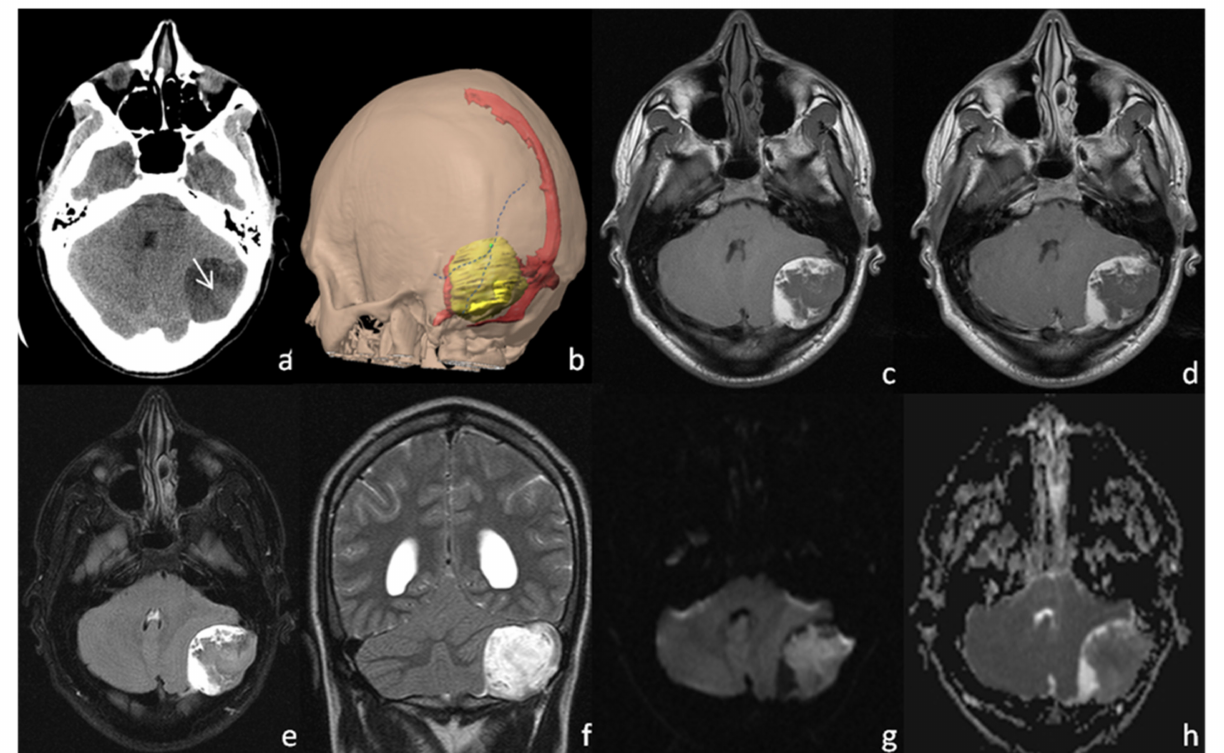
Figure 2. Case 2: CT scan ( a ) showing a hypodense left asterional lesion with a central, slight hyper- dense area ( a , white arrow), corresponding to an area of diffusion restriction on DWI/ADC ( g , h ). A 3D pre-surgical reconstruction model ( b ) was performed to correctly identify the relationships among the asterion (green dot), which is the intersection of parietomastoid, lambdoid and occipitomastoid sutures (blue dotted lines), the dermoid cyst (yellow) and the adjacent venous system (red). The 1.5 T MRI ( c – h ) showing a prevalently hypointense left asterional mass, with no contrast enhancement after gadolinium administration ( d ). A similar hyperintense rim is noted on FLAIR ( e ) and T2WI ( f ), whereas the mass appears to be more hyperintense on T2WI than on